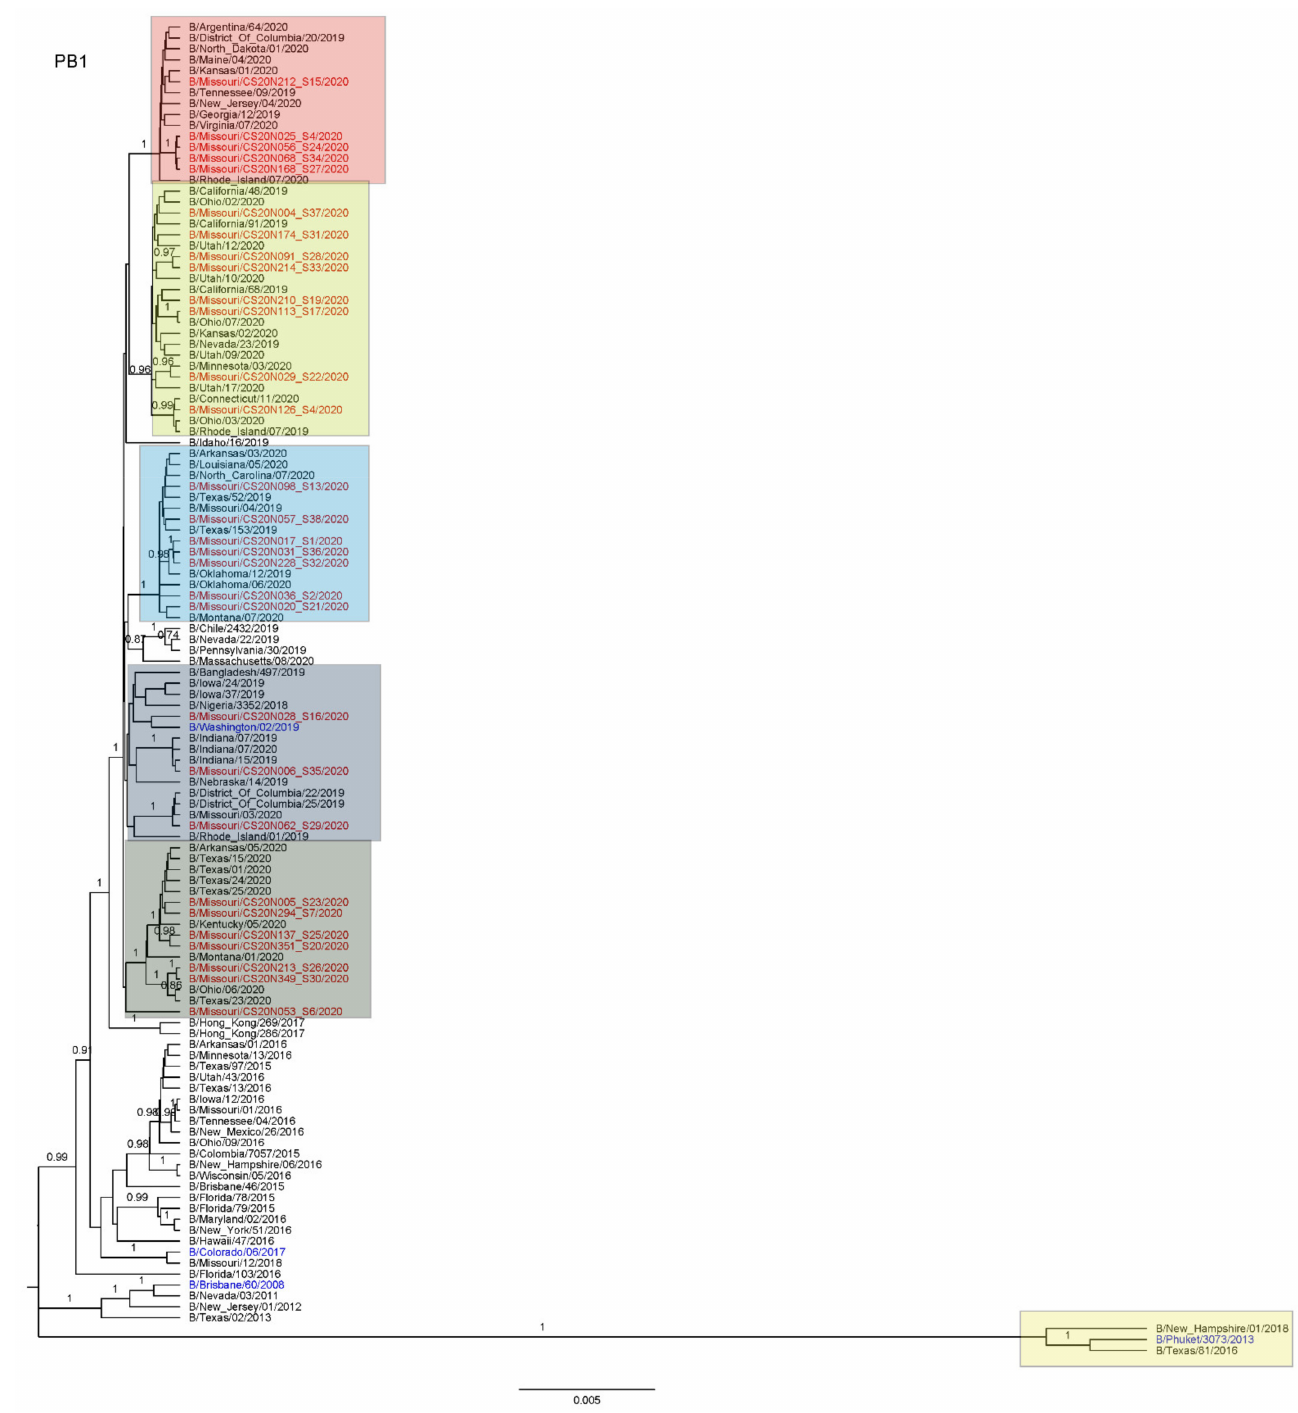
Figure A2. PB1 Tree. The phylogenetic analyses were performed by using BEAST2 with a Hasegawa–Kishino–Yano (HKY) substitution empirical model, strict clock model, and coalescent constant population prior. Branches with a posterior probability >0.70 were